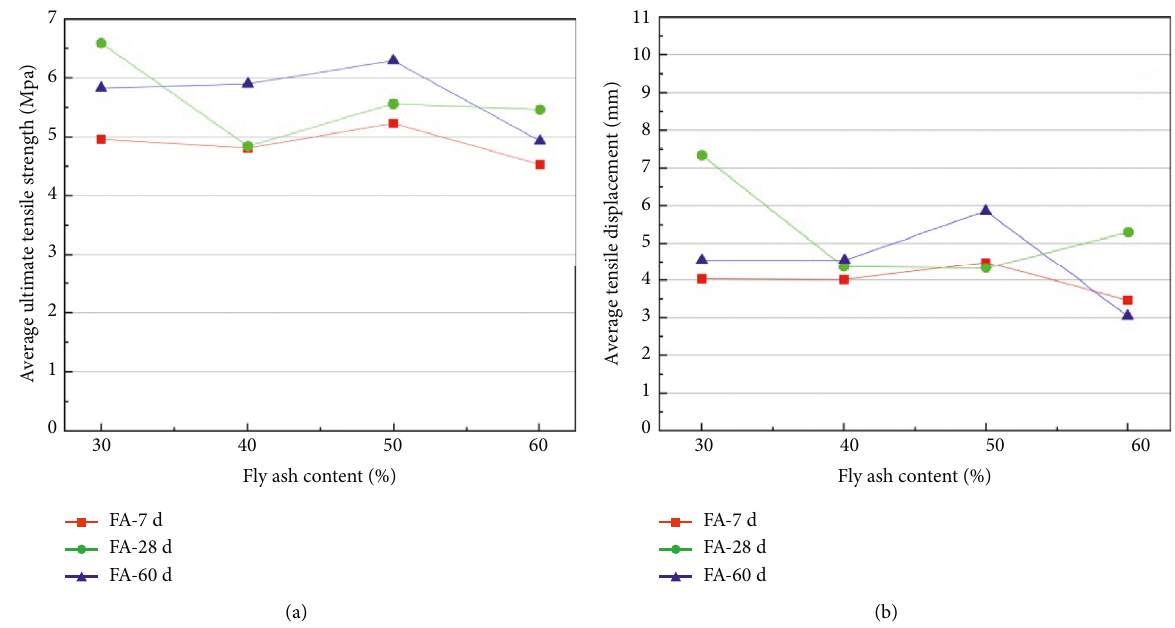
Figure 9: The effect of fly ash content: (a) average ultimate tensile strength, (b) average tensile